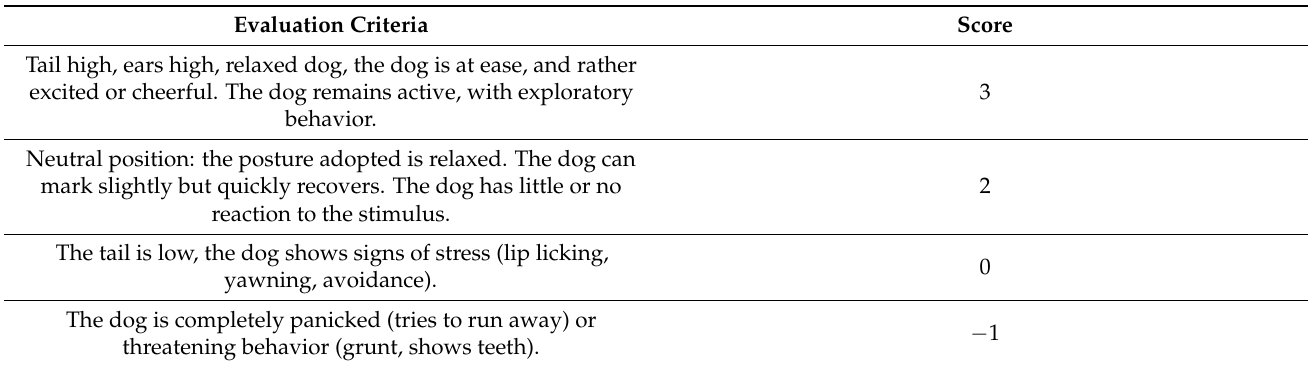
Table 2. Emotional reactivity test score grid for each item.